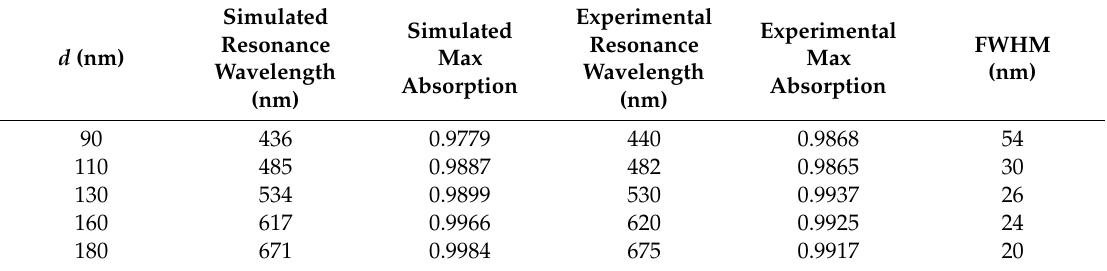
Table 2. The experiment and simulation results at resonance wavelengths for five di ff erent